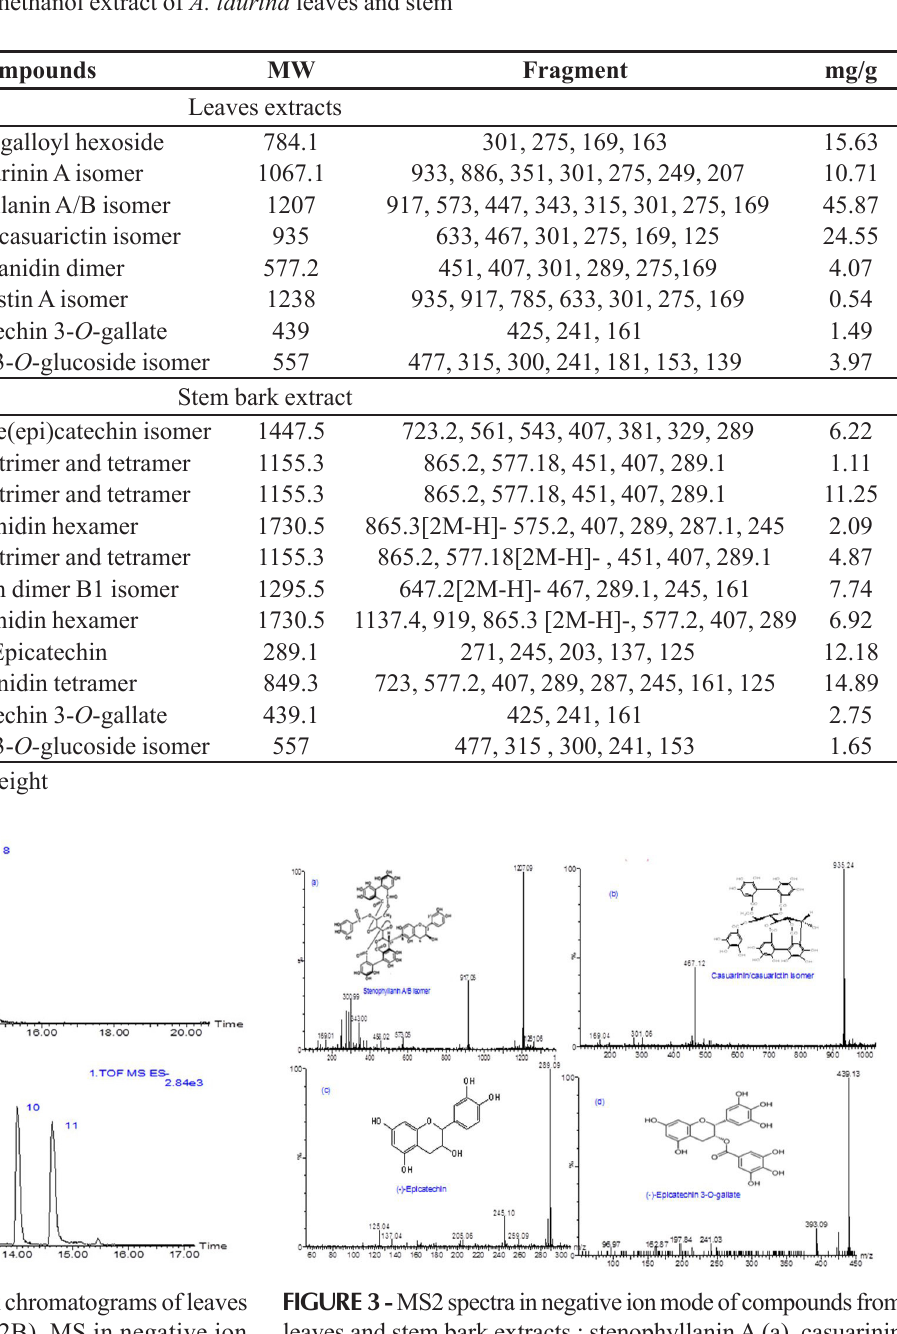
leaves and stem bark extracts : stenophyllanin A (a), casuarinin (b), (-)-epicatechin (c) and (-)-epicatechin-3- O -glucoside (d).